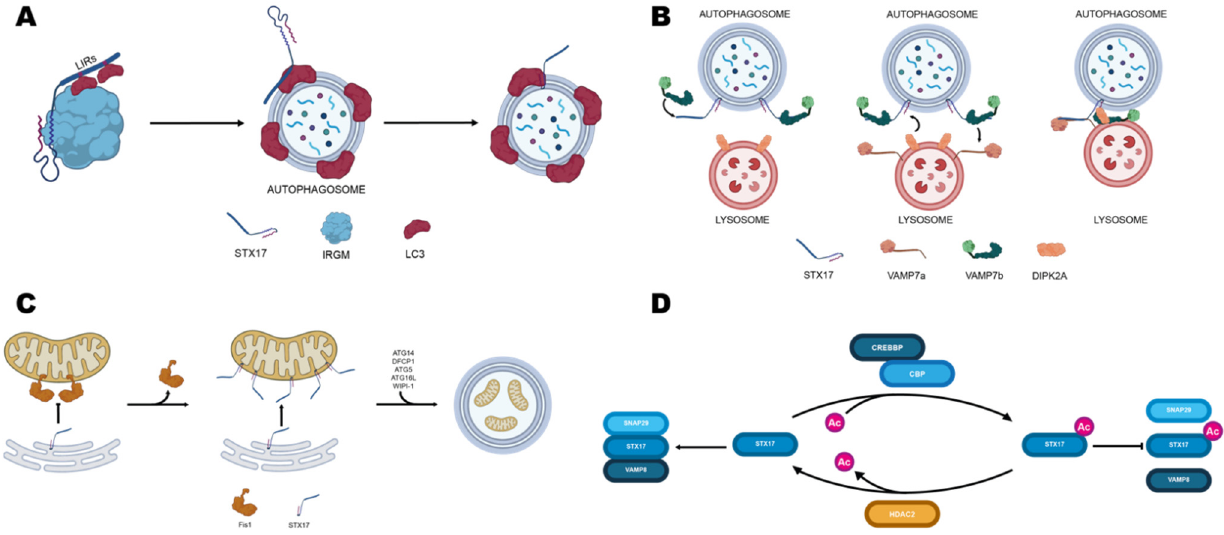
Figure 2. Role of STX17 in autophagy and mithophagy. ( A ) Schematic model for STX17 recruitment to autophagosomes, as reported by Kumar and co-workers. Image was adapted from reference [137]. ( B ) Schematic model for STX17 interaction with VAMP7a, VAMP7b, and DPIK2a in mediating endosome-lysosome fusion as proposed by Tian and co-workers [133] ( C ) Schematic model of STX17-induced mitophagy upon mitochondrial fission 1 protein knockout. Image was adapted from reference [138]. ( D ) Interplay between histone acetylase and deacetylase regulates STX17 ability to mediate autophagosome fusion with lysosomes.